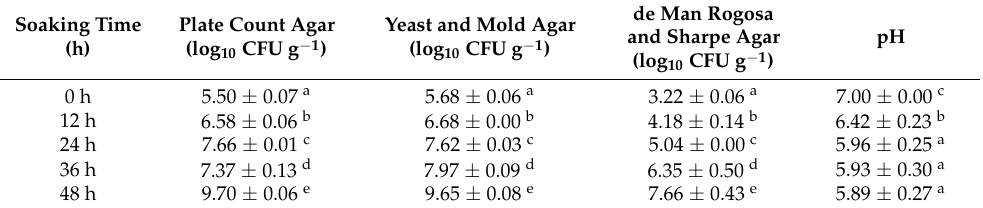
Table 1. Microorganism colony counts in various culture media and pH Value. Soaking Time